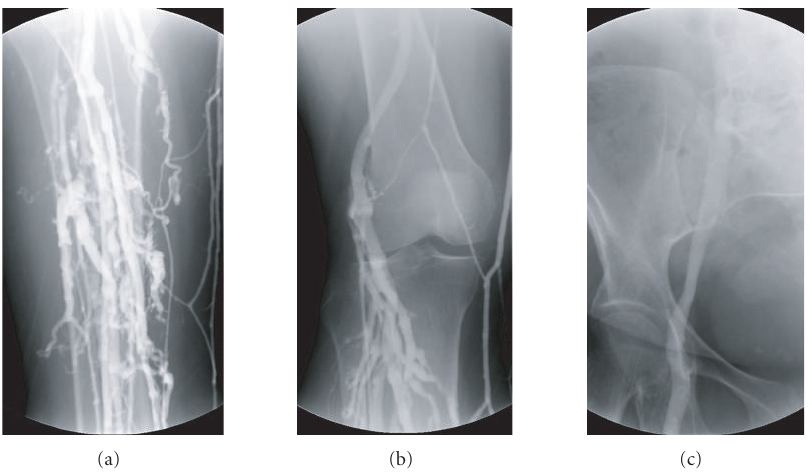
Figure 1: Normal phlebography. (a) Calf veins. (b) Popliteal vein. (c) Femoral vein at the groin and iliac vein at the